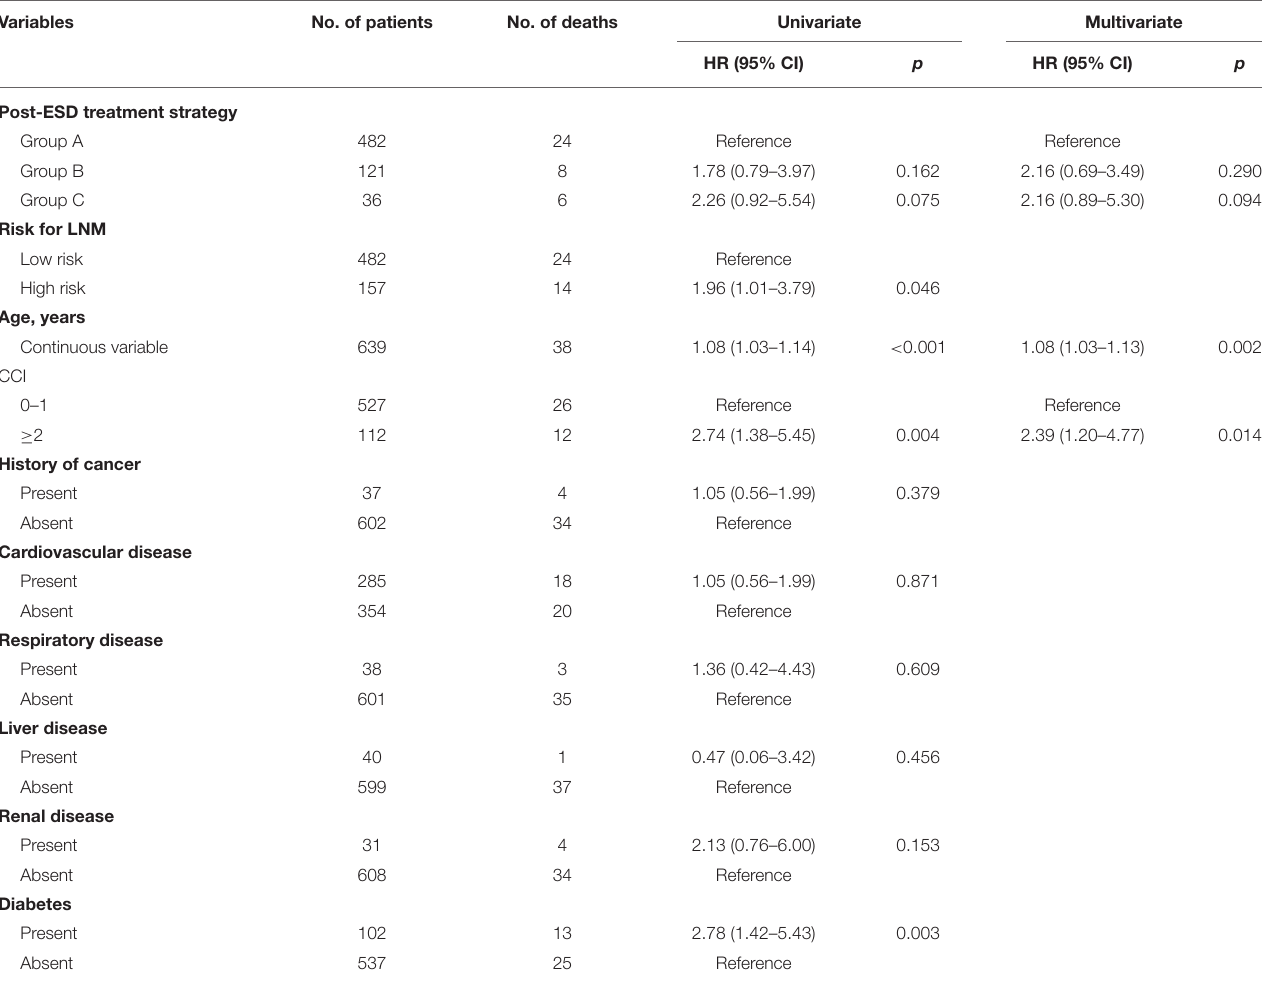
TABLE 3 | Risk factors associated with poor overall